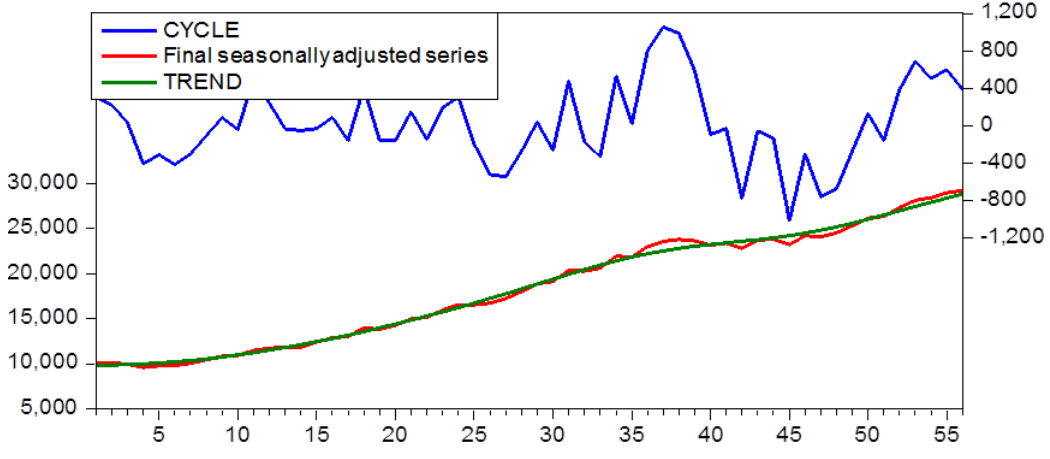
Figure5. Cycles, trend and final seasonally adjusted series of industrial value added